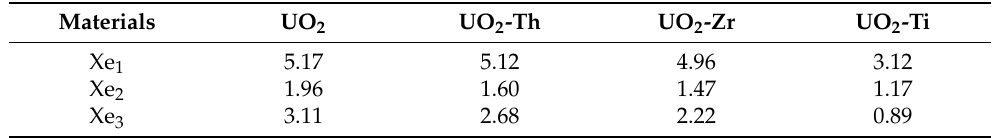
Table 5. Relationship between binding energy (eV) and number of Xe atoms in pure UO 2 , UO 2 -Th, UO 2 -Zr, and UO 2 -Ti